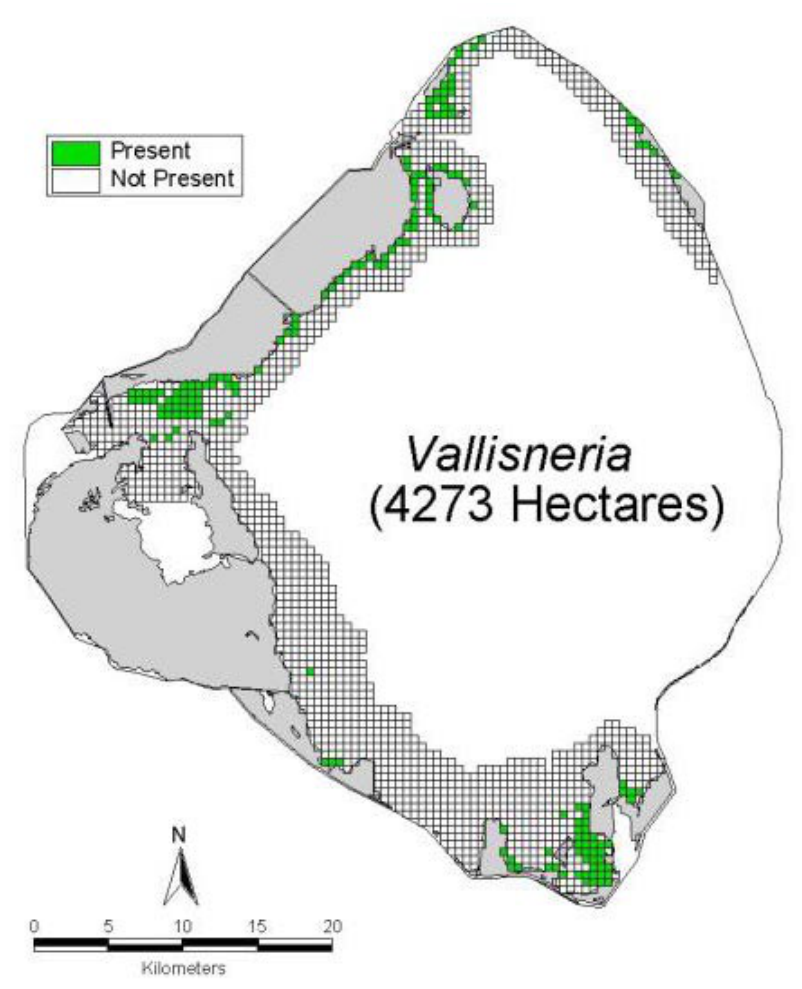
FIGURE 2 . GIS maps showing the spatial distribution of (A) Vallisneria americana, (B) Hydrilla verticillata, (C) Potamogeton illinoensis, (D) Ceratophyllum demersum, and (E) Chara spp. in Lake Okeechobee during late summer 2000. Each square is 500 x 500 m. The light gray shaded area along the western shoreline is the lake‘s littoral zone of emergent vegetation. The white area is deeper water that was not mapped. The model using these three decision rules correctly predicted 75% of the observed spatial distribution of Chara (Fig. 4B). The only notable area of underprediction occurred in the north and along the western shore, where qualitative sampling (into categories of sparse, moderate, dense) suggested that the biomass of Chara was